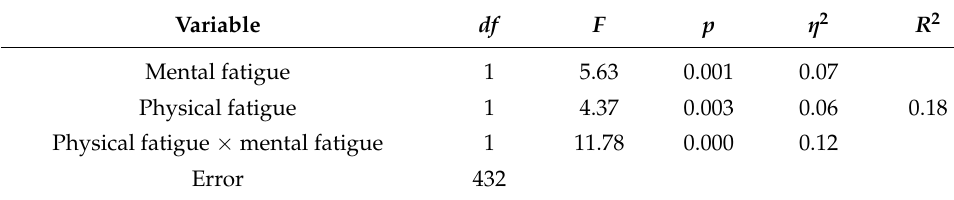
Table 6. Multi-factor analysis of